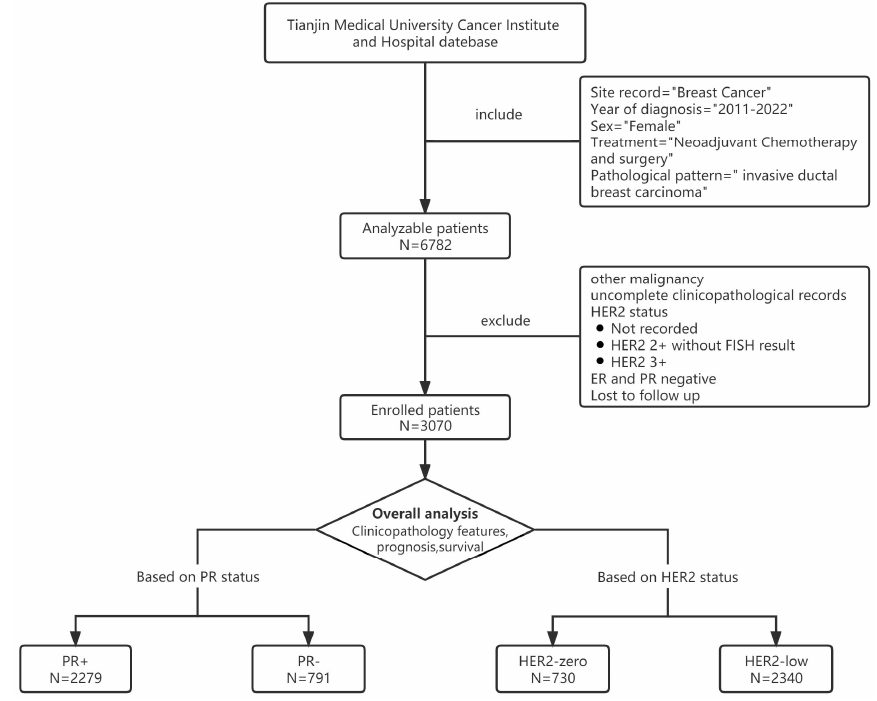
Figure 1. Patient selection flowchart for this study. Table 1. Baseline patient characteristics and log rank test of DFS and OS.